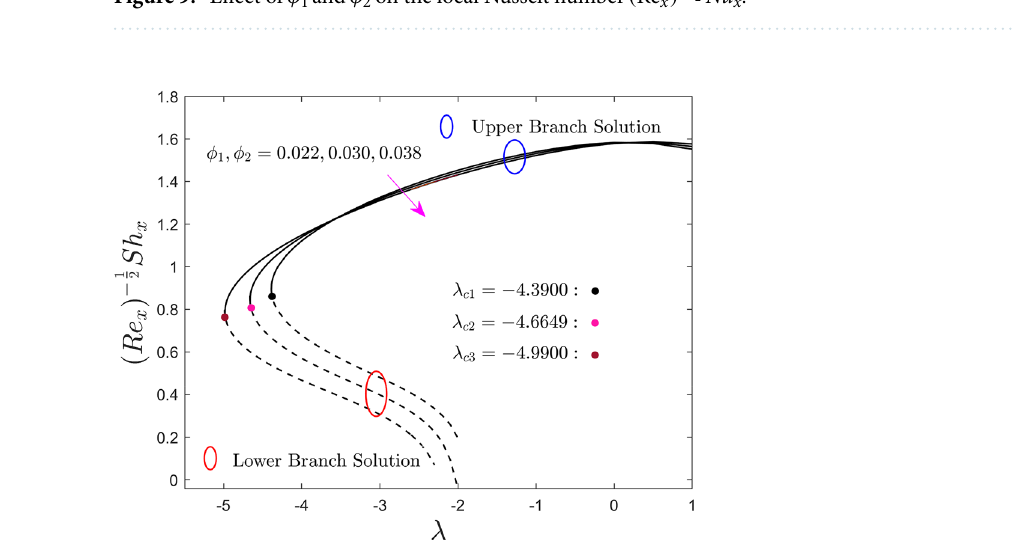
Figure 9. Effect of φ 1 and φ 2 on the local Nusselt number ( Re x ) −